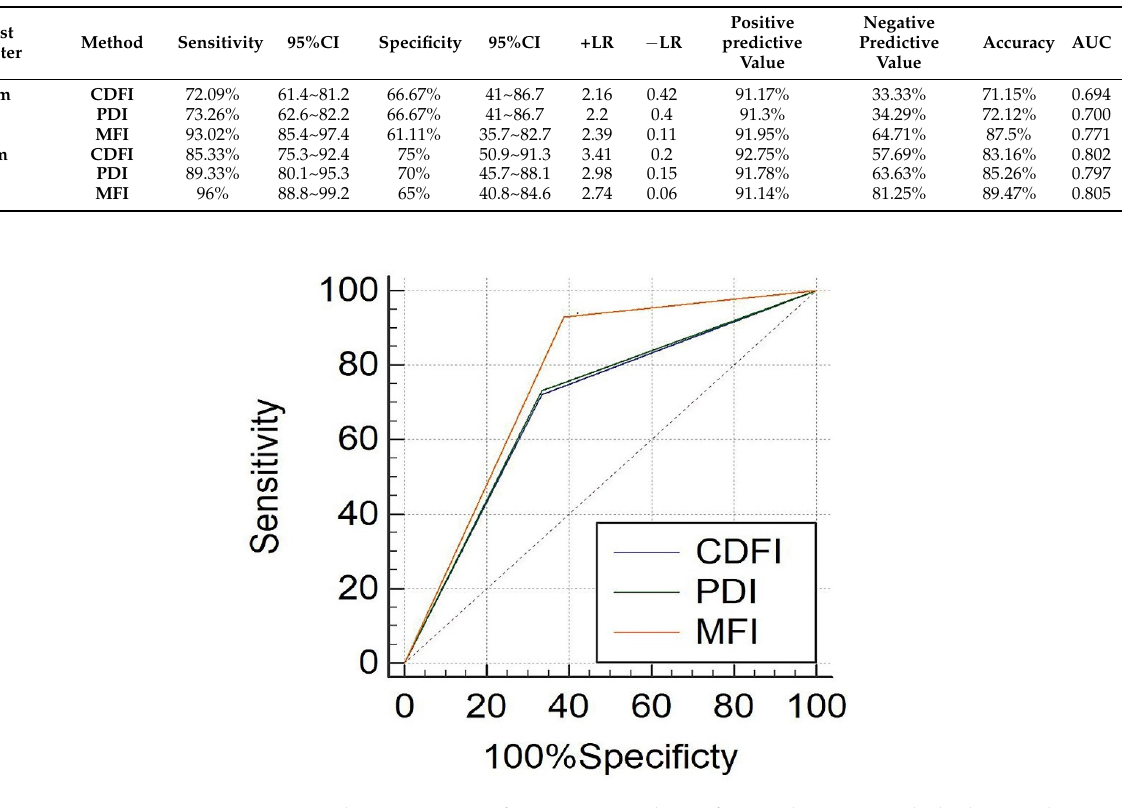
Figure 5. The ROC curve of CDFI, PDI and MFI for renal tumors with the largest diameter ≤ 4 cm.